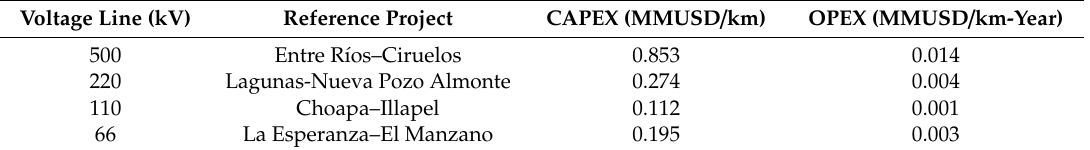
Table 3. CAPEX and OPEX in the transmission lines as a function of distance [36]. Voltage Line (kV)